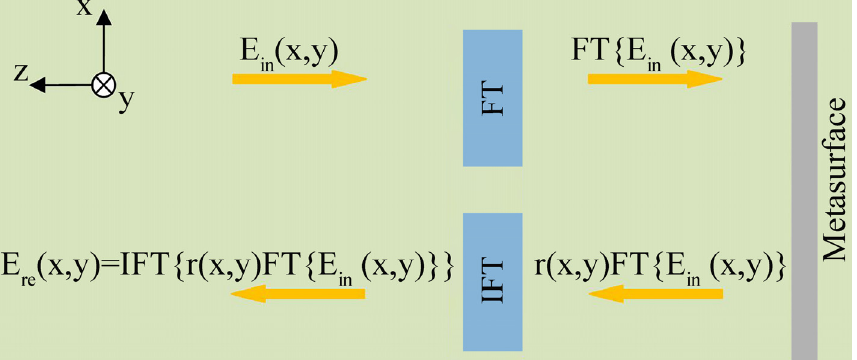
Figure 1. A schematic showing mathematical operation on a reflective metasurface. The system consists of an FT module, an inverse FT (IFT) module, and a metasurface with a position-dependent reflection coefficient r(x, y).